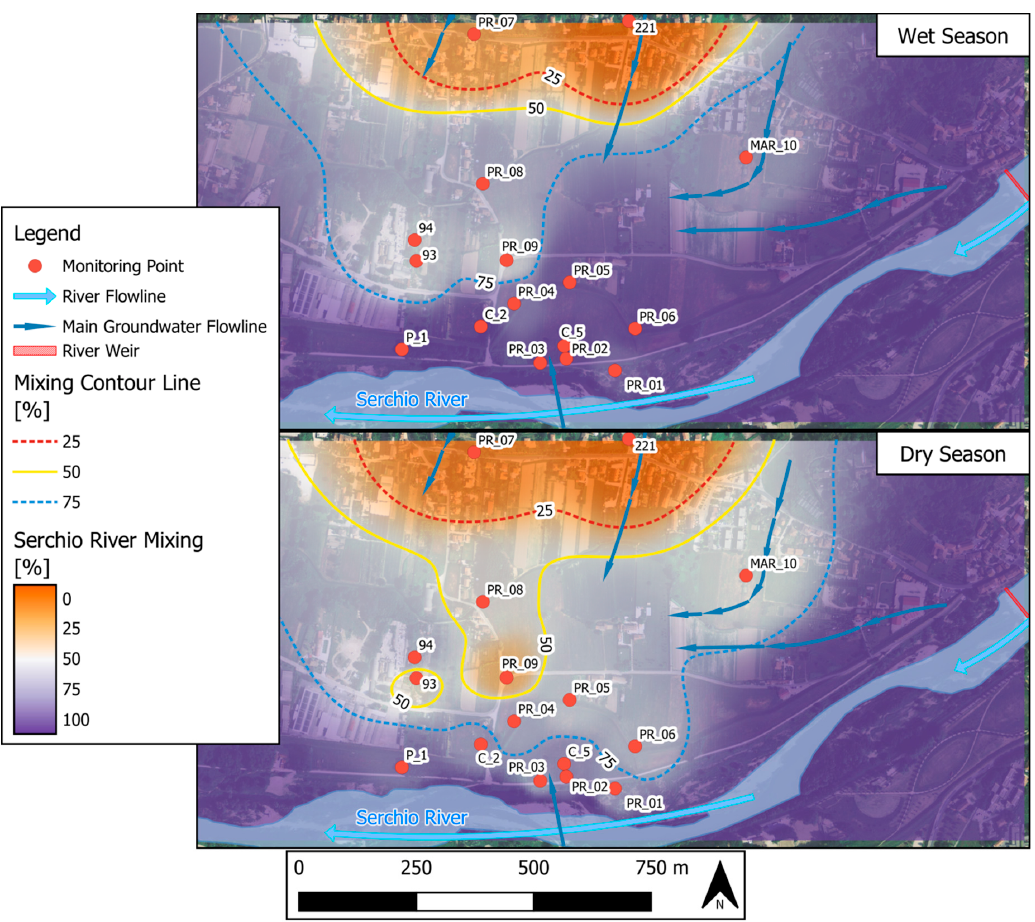
Figure 12. Interpolation showing the Serchio river influence on the Sant’Alessio aquifer and the Serchio River RBF, using lithium as tracer.